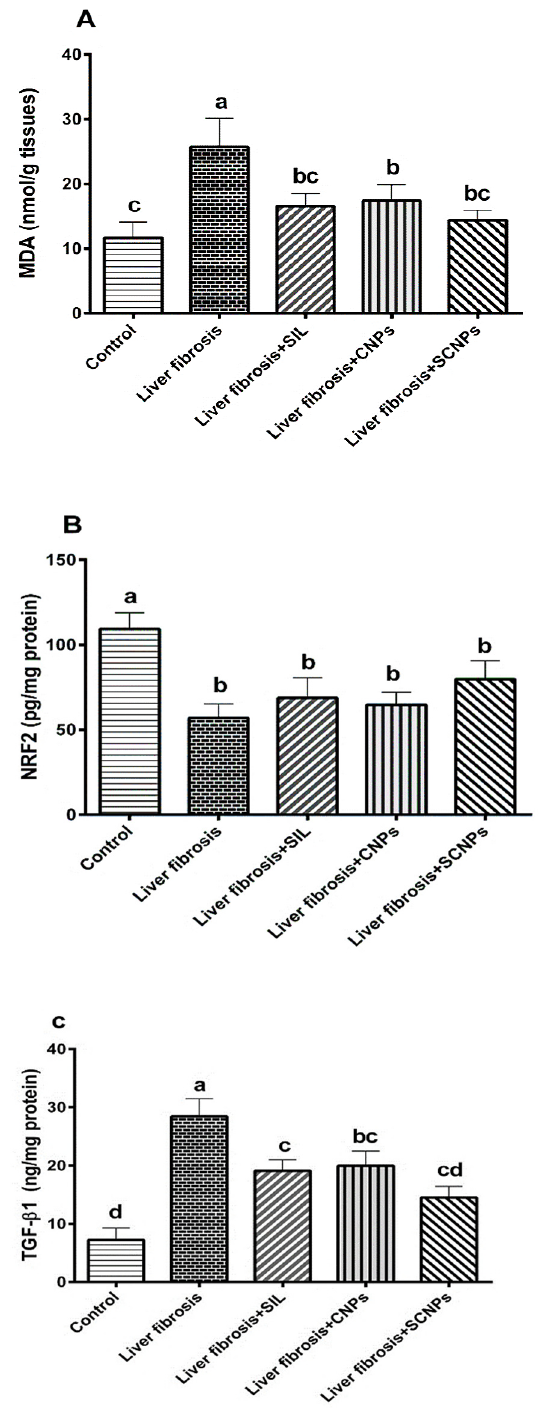
Figure 6. Effect of different groups on ( A ) MDA; ( B ) NRF2; ( C ) TGF- β levels in hepatic tissue homogenate. Data are presented as mean ± SD ( n = 6). The means of the groups in the same column with the same superscript letter are not significantly different, while the means with different letters are significantly differed according to the ANOVA test, followed by the post hoc test (Tukey). At p ≤ 0.05, the difference was statistically significant. Abbreviations: MDA, malondialdehyde; NRF2, nuclear factor-erythroid 2-related factor 2; TGF- β , transforming growth factor- β